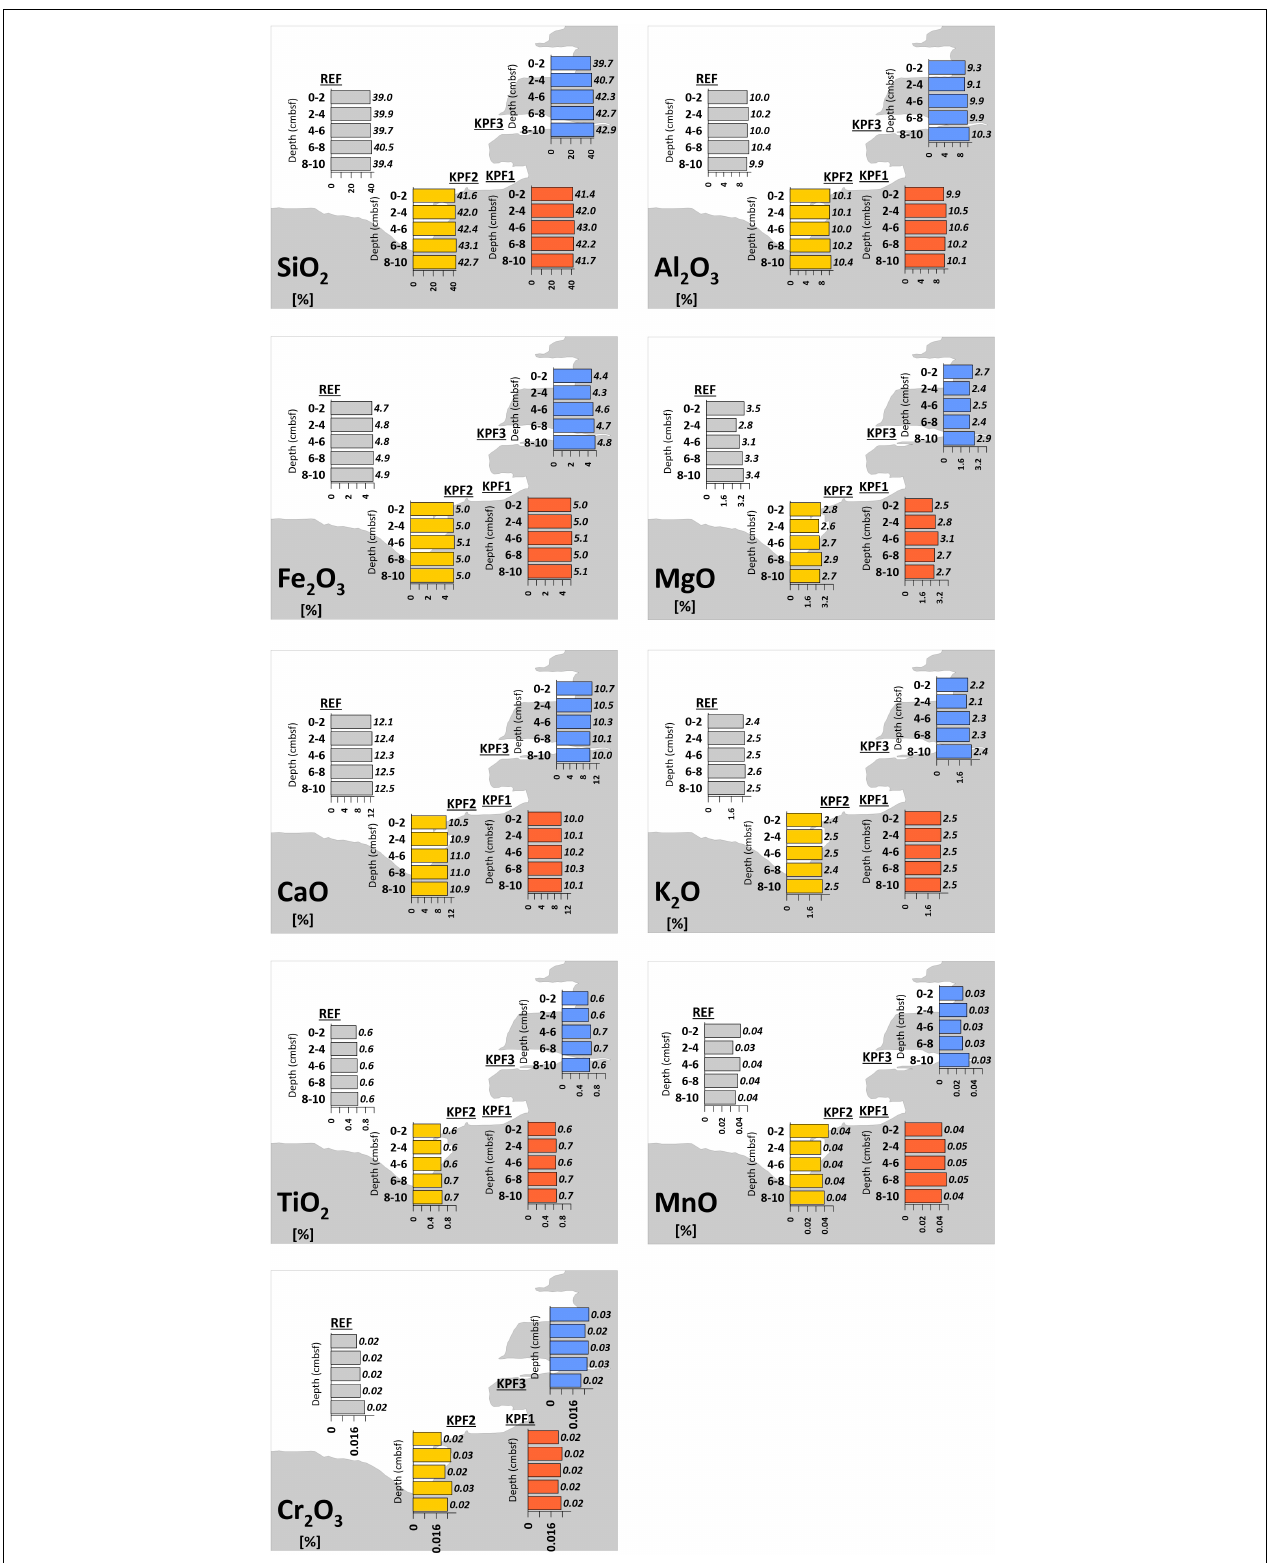
FIGURE 3 | Major oxides concentrations (%) of sediments of Bay of Koper (cmbsf = cm below sediment floor).